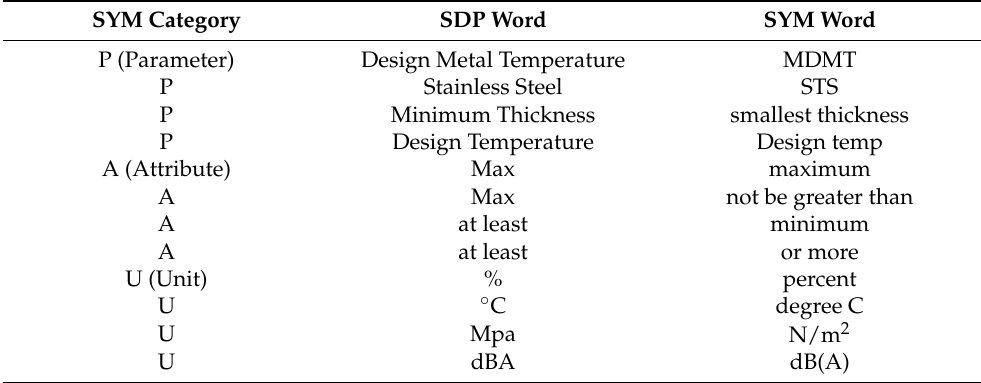
Table 5. Synonym dictionary of DPE.